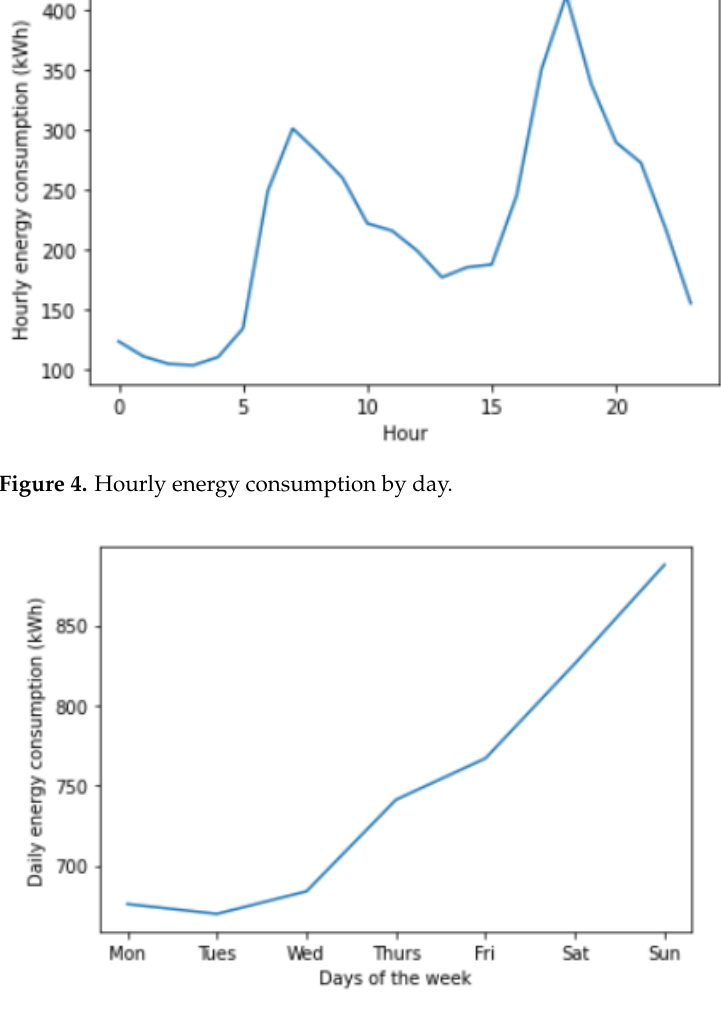
Figure 5. Average daily energy consumption by week.